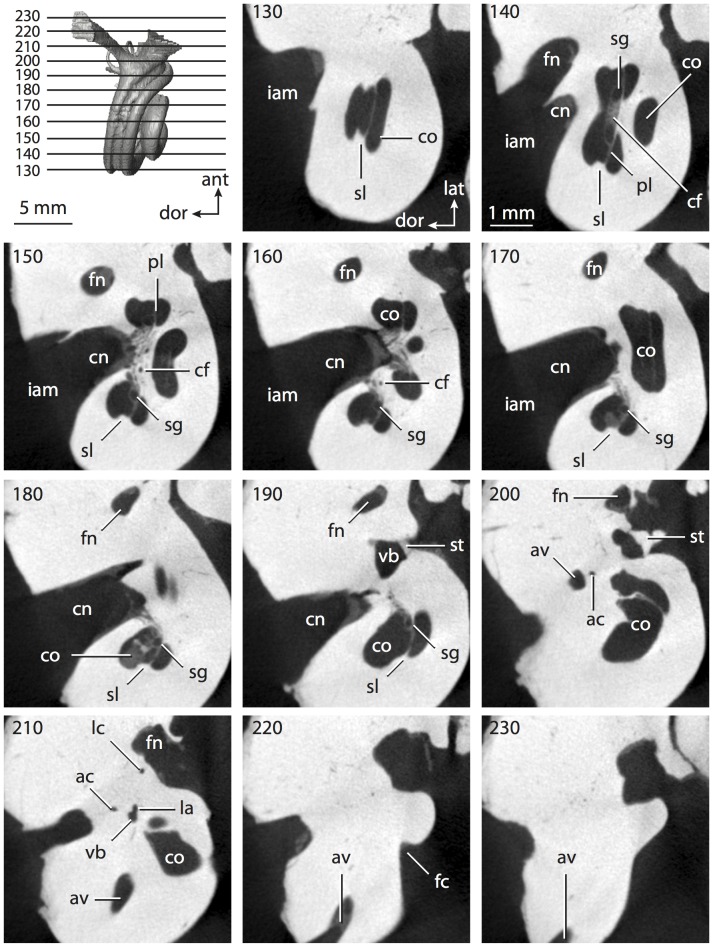
CT slices through ear region ofTursiops truncatus.Abbreviations listed at the end of the Materials and Methods section.